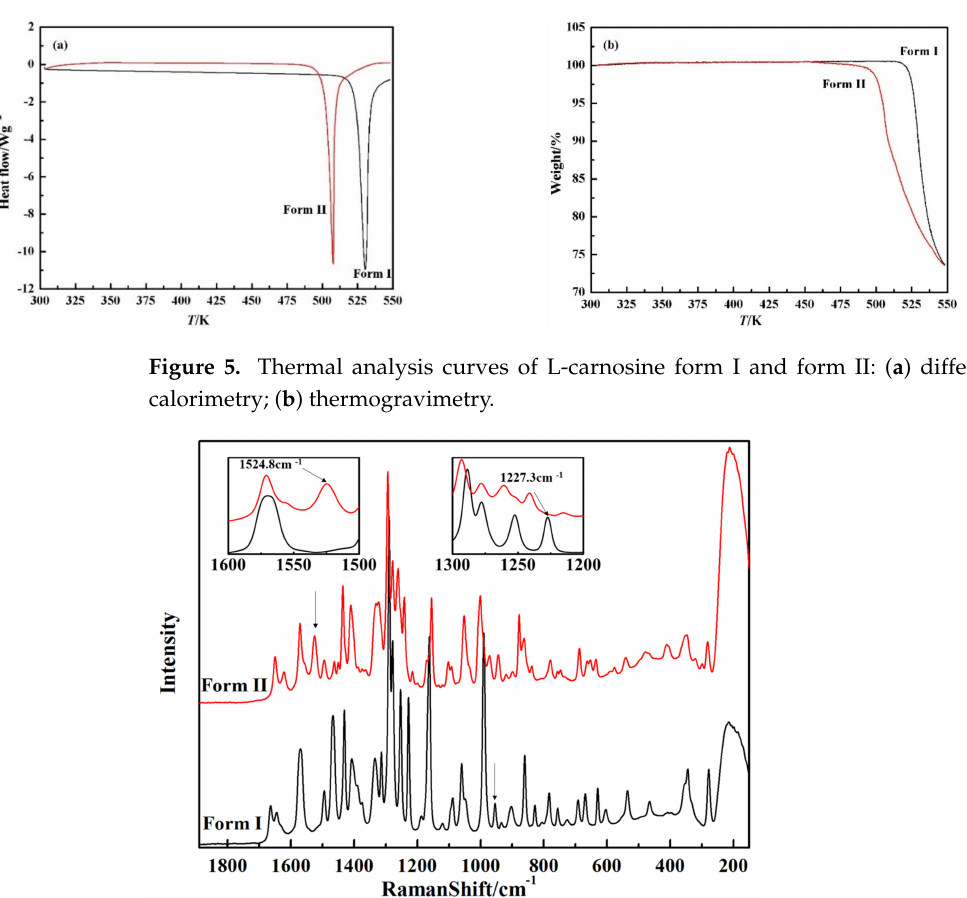
Figure 6. Raman spectra of L-carnosine form I and form II.